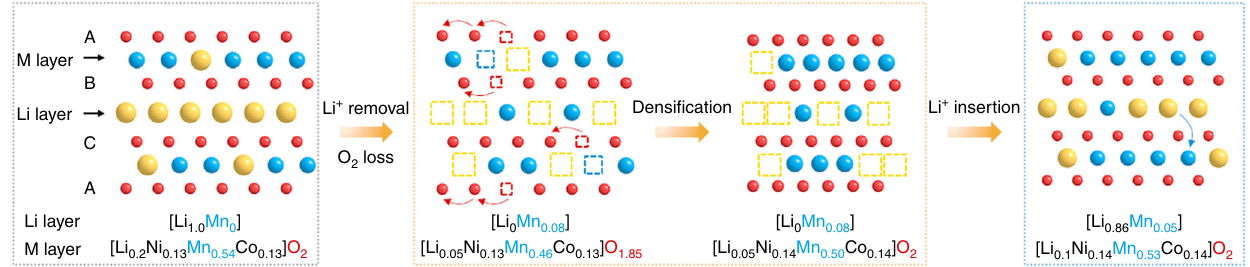
Fig. 8 Schematic of the A → A ′ → P ′ phase transition. Delithiation and oxygen evolution create vacancies in both cationic and anionic sublattices upon charge to above 4.6 V in the fi rst electrochemical cycle. The oxygen vacancies are re fi lled implying their long-range migration from bulk to surface with subsequent annihilation. The vacant Li sites are partially re fi lled with the M cations causing their appearance in the octahedral interlayer sites and suppressing the “ honeycomb ” Li-M cation ordering. As a result, M/O atomic ratio increases that is considered as “ densi fi cation. ” During subsequent discharge, the M cations partially move back to their original positions and the vacant cationic sites are fi lled with Li + . Li: yellow symbol; Li vacancy: dash yellow square; transition metals (Ni, Mn, Co): blue symbol; transition-metal vacancies: dash blue square; oxygen: red symbol; oxygen vacancy: red dash